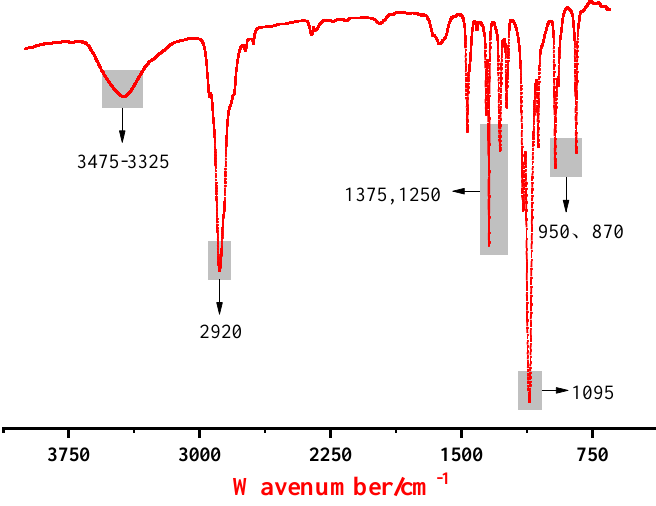
Figure 5. Infrared spectra of dielectric microcapsules.